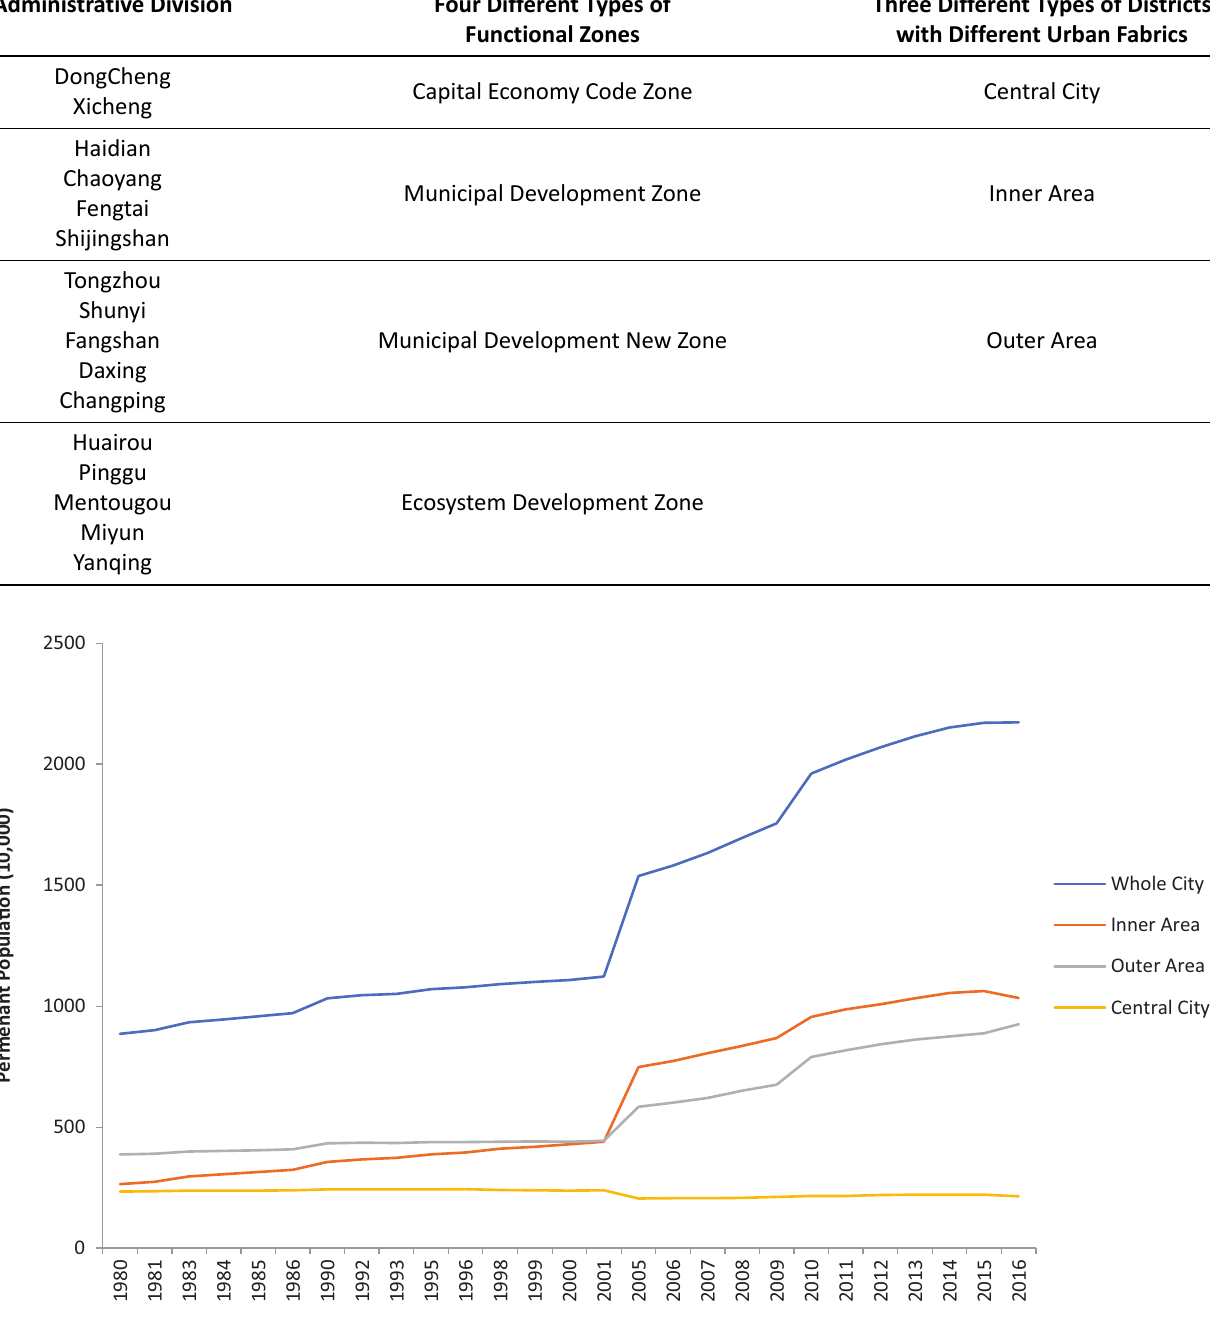
Figure 7. Changing spatial distribution of population in Beijing (10,000) from 1980 to 2016. Source: Compiled based on data provided by the Beijing Municipal Bureau of Statistics (BJMBS, 1982–2015,